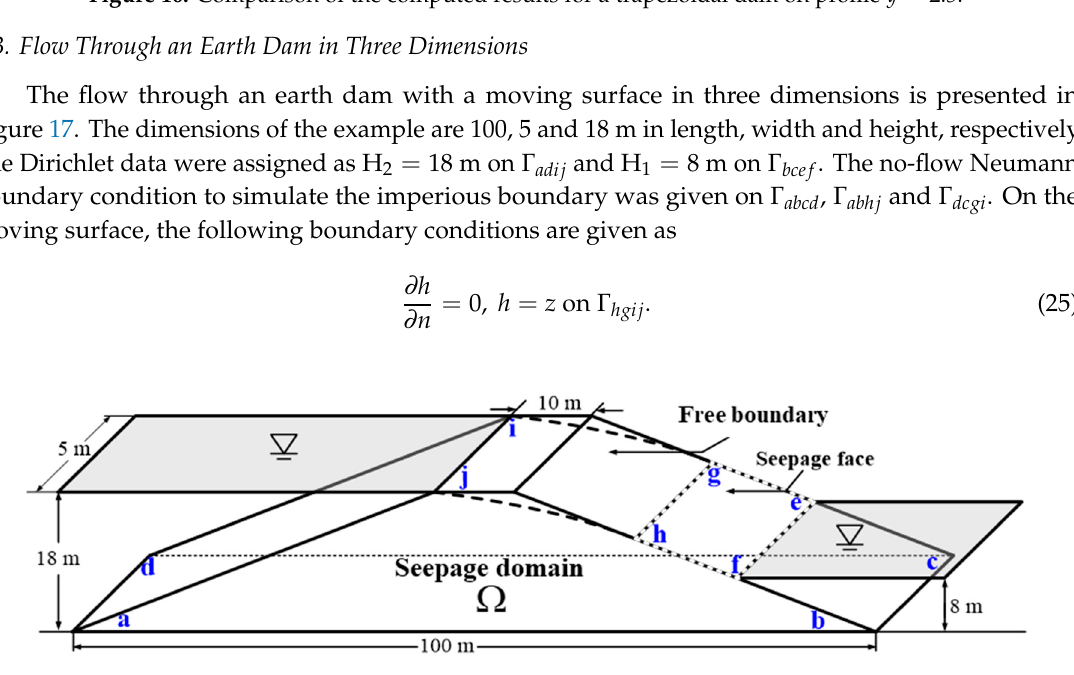
Figure 16. Comparison of the computed results for a trapezoidal dam on profile y = 2.5.